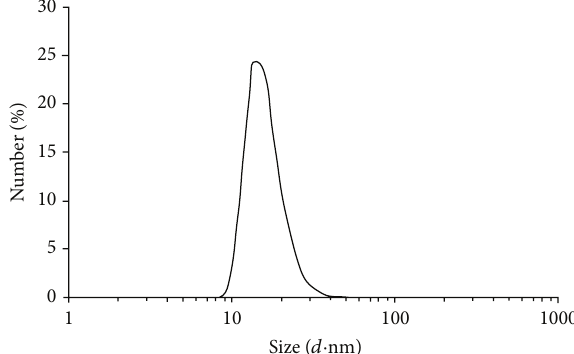
Figure 4: Particle size distribution of the colloidal titania sol.